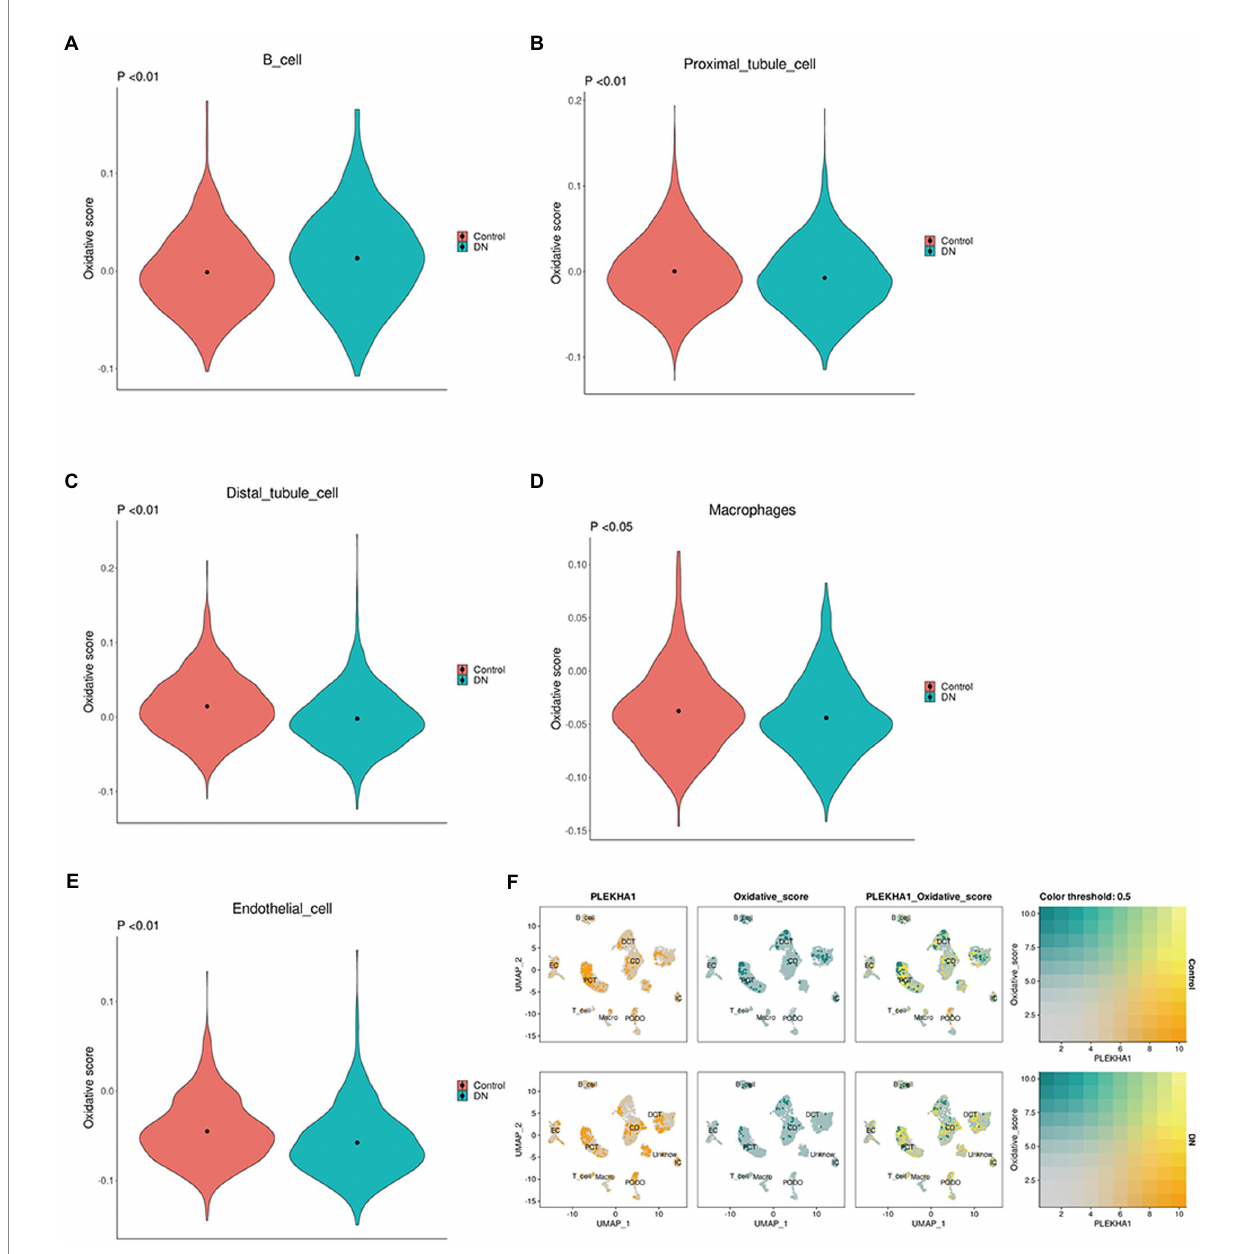
FIGURE 7 Association between the PLEKHA1 gene and single-cell oxidative phosphorylation. (A–E) Violin plot of potential biological markers and single-cell oxidative stress in DN: B cell. Proximal tubular cell. Distal tubular cell. Macrophages. Endothelial cell. (F) The relationship between PLEKHA1 and single- cell oxidative stress in DN was demonstrated by UMAP